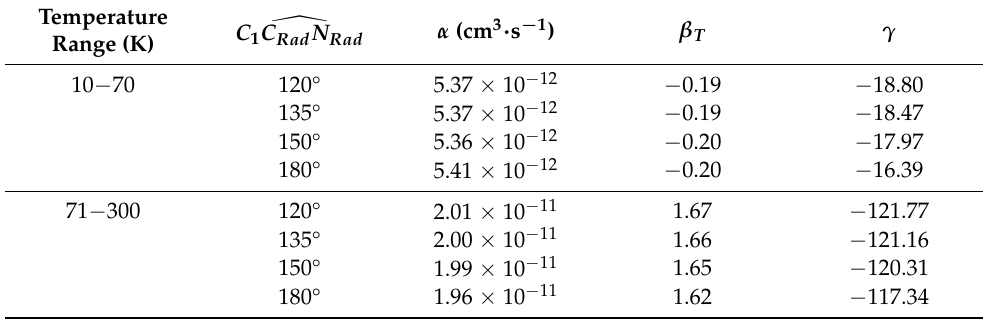
Table 3. Values of α , β T and γ coefficients for the modified Arrhenius equation (Equation (8)).